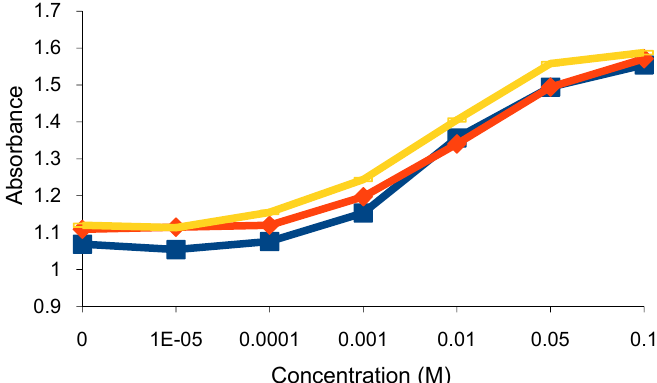
Figure 8. Turbidity absorbance of sensing element vs. concentration of Hg 2+ after one ( ), two ( ) and three ( ) weeks.